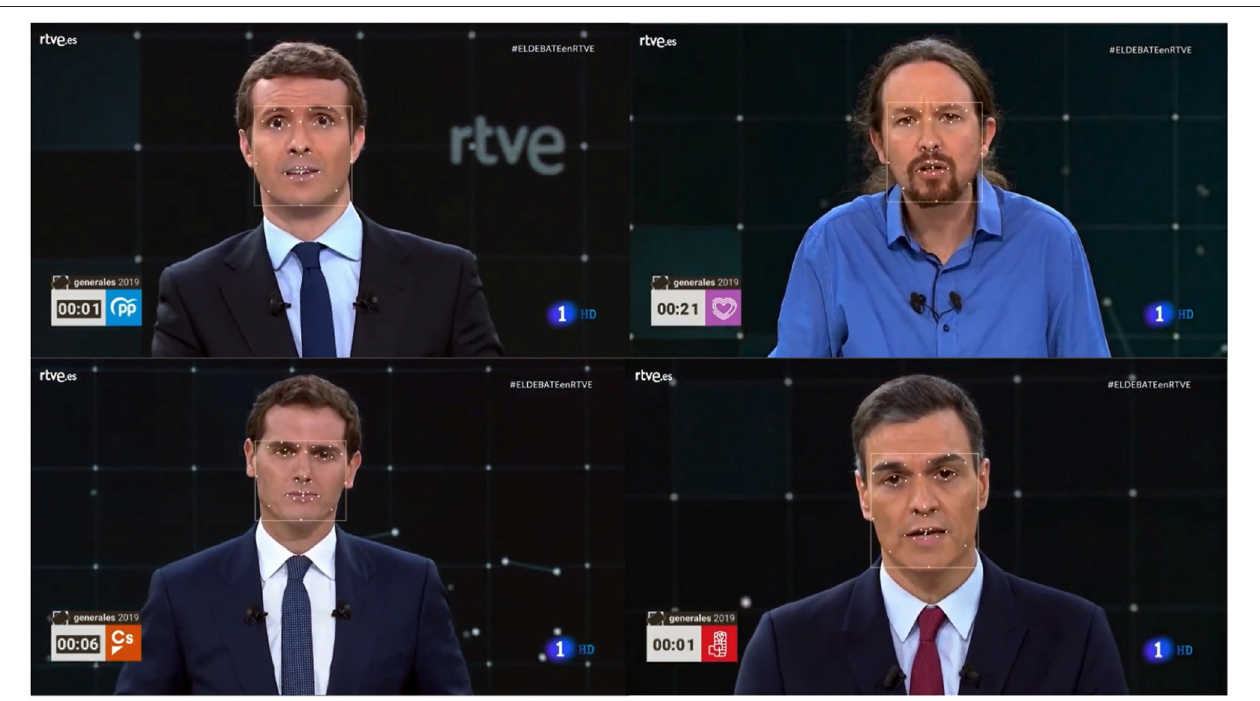
FIGURE 2 | Application of Facial Expression Analysis on the four candidates using Affdex